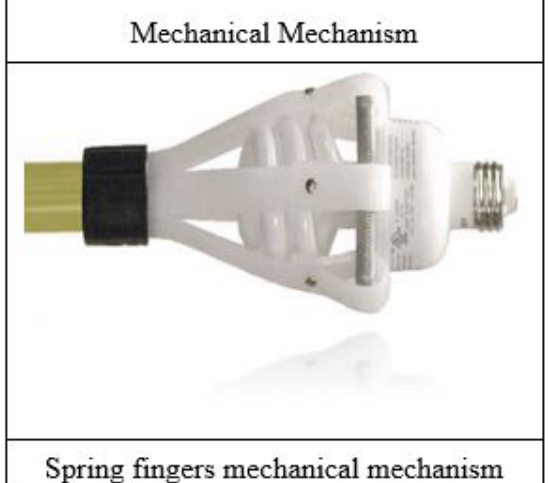
Figure 4. Mechanical